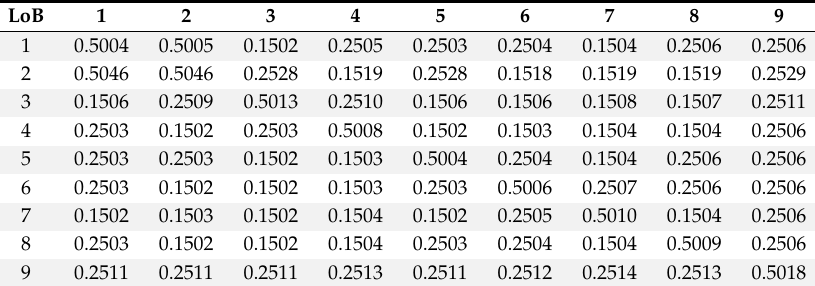
Table 8. Correlation block for the marginalized model: Ω PY , CY , s .